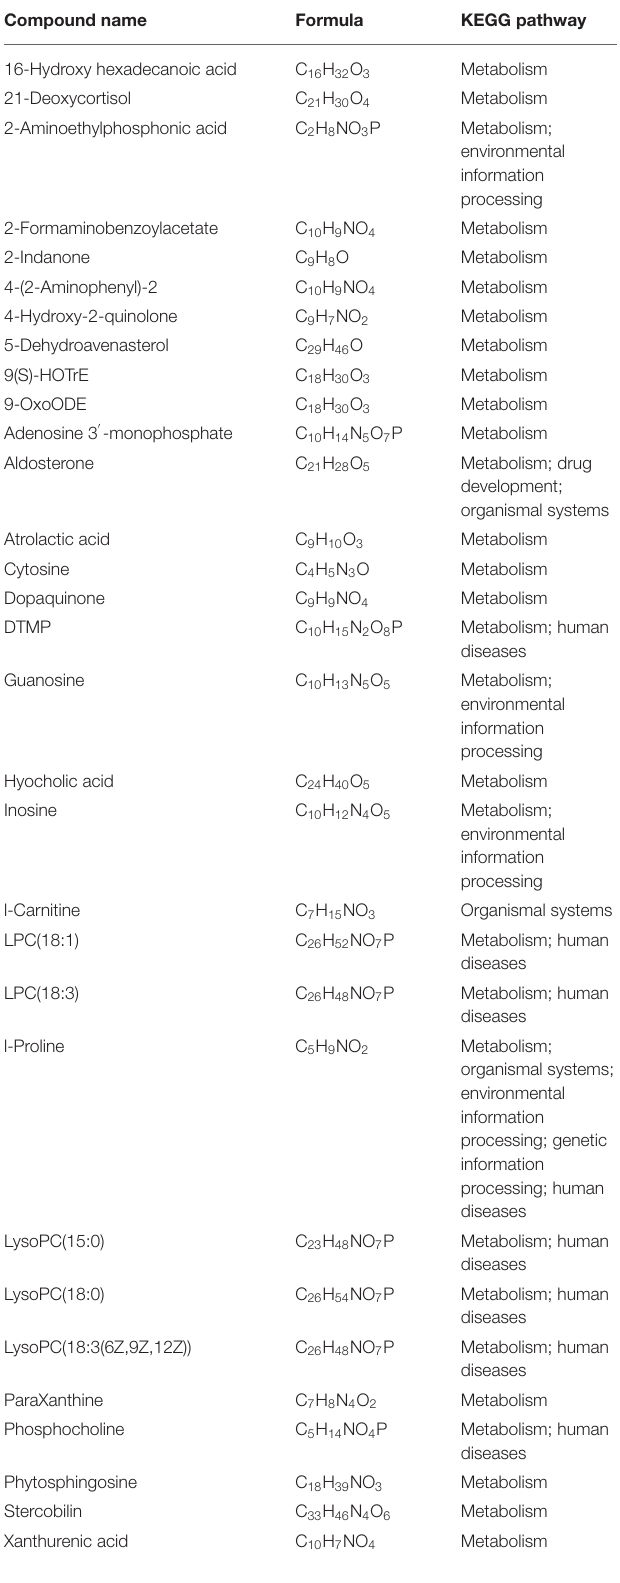
TABLE 1 | Functions of named 31 metabolites which showed significant differences between M-PATPHs and